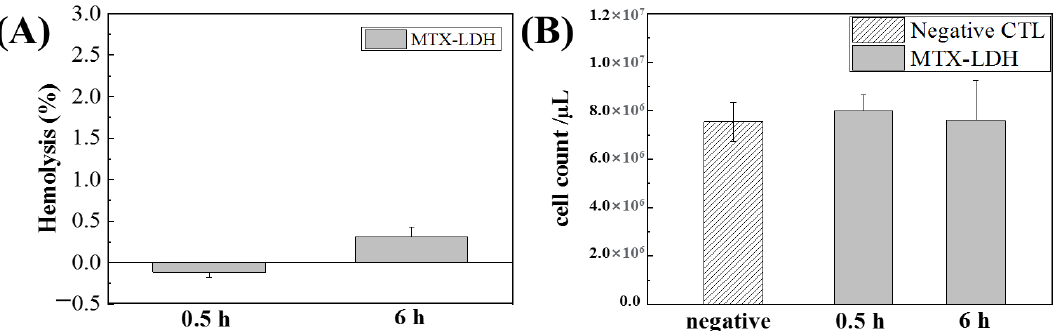
− Figure 5. In vivo ( A ) hemolysis and ( B ) red blood cell number counting assay results of MTX-LDH after 0.5 and 6 h of injection to a Balb / c mouse. The MTX-LDH suspension (10 mg / mL) was injected (100 µ L) through the tail vein, and the blood was analyzed at each time